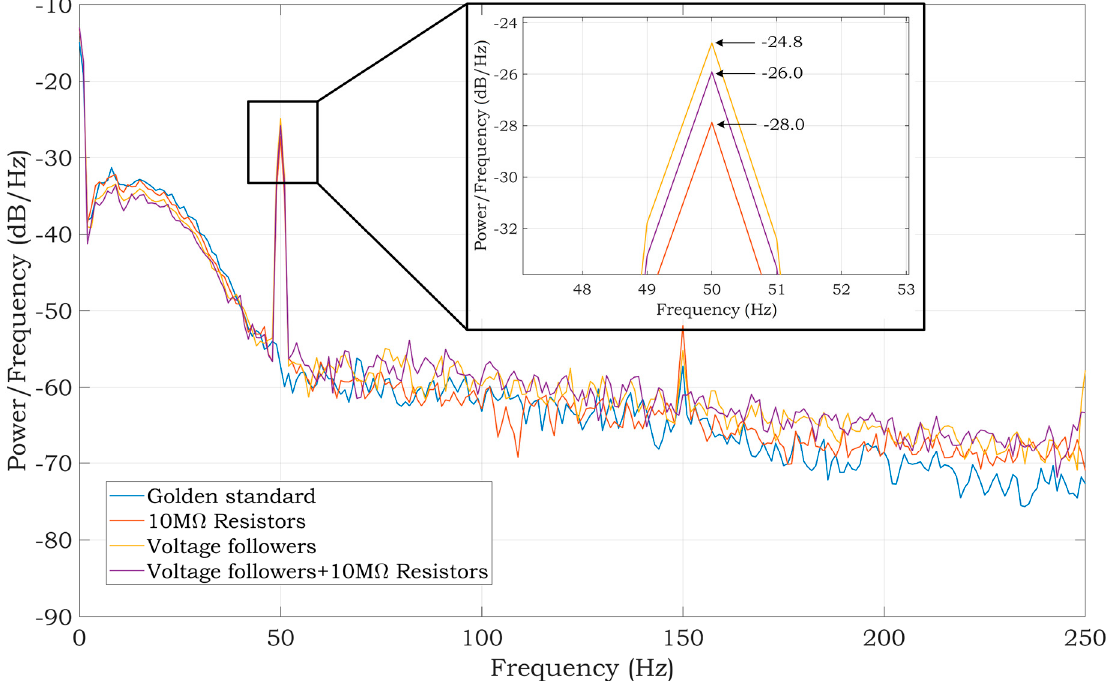
Figure 11. PSD estimates of raw ECG signals measured from a living subject. The power of the golden standard signal at 50 Hz is − 56.67